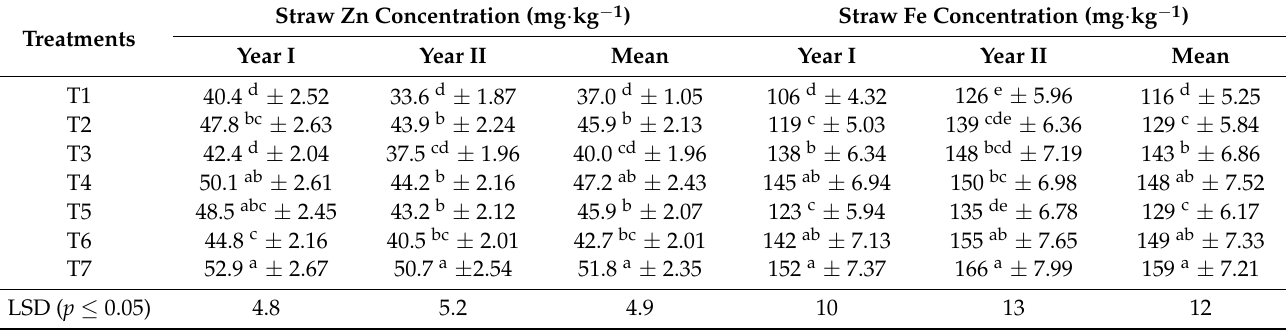
Table 4. Effect of biofortification on Zn and Fe concentration in straw of lentil.